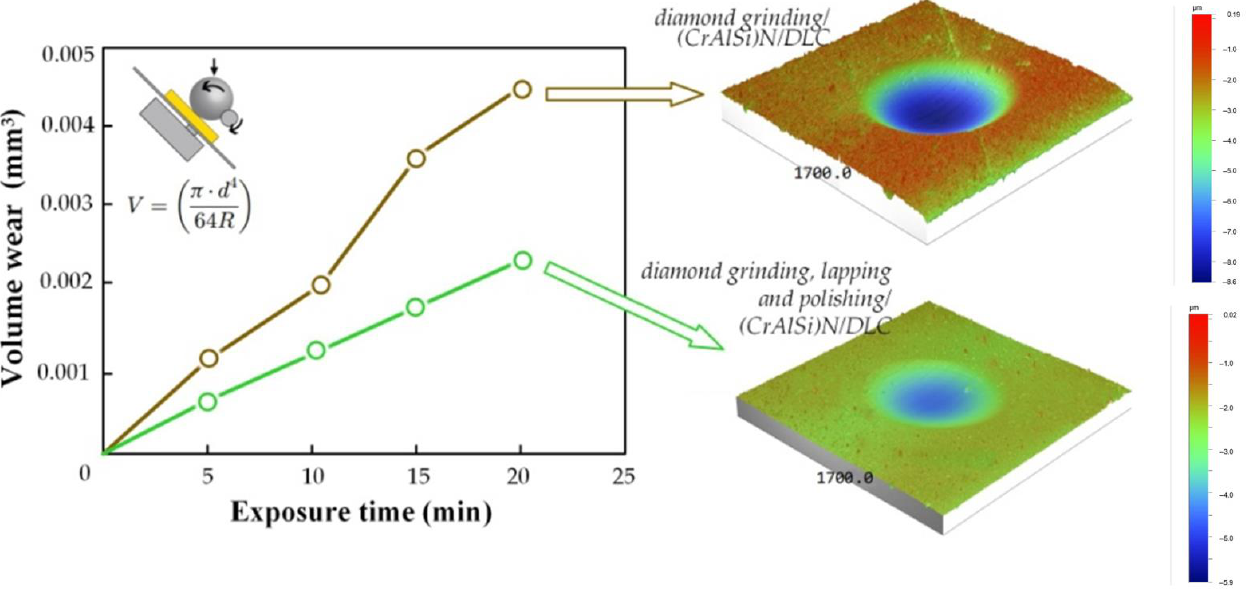
Figure 13. Dependences of the volume wear of SiAlON ceramic inserts with (CrAlSi)N/DLC coatings deposited on samples after various diamond abrasive machining methods on the abrasive exposure time.